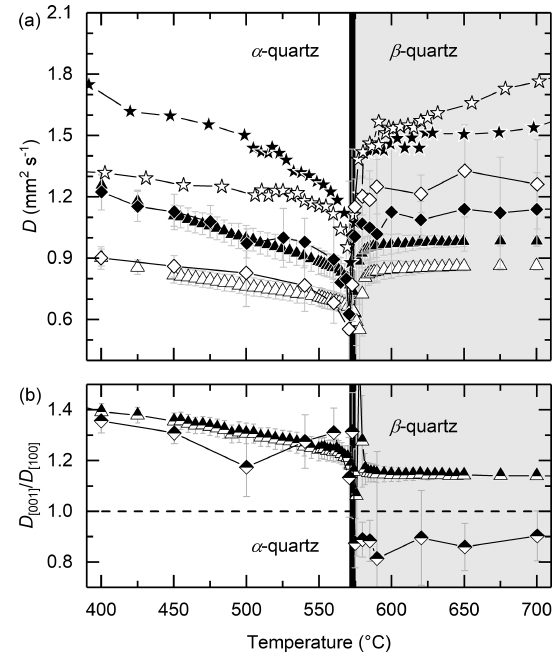
Figure 4. (a) Thermal diffusivities in the [001] (black filling) and [100] directions (white filling) measured for a cubic quartz speci- men with thickness d ∼ 10mm (diamonds) in comparison to HT1 data (upwards triangles, this study) and measurements given by Höfer and Schilling (2002) (stars). A crossover in the crystallo- graphic direction of the maximum thermal diffusivity is observed for the thick cubic specimen as it was measured for tall cylinders by Höfer and Schilling (2002). (b) Anisotropy of the thermal diffu- sivity shown for HT1 (upwards triangles) compared to data of the cubic quartz specimen (diamonds). The crossover in the thermal dif- fusivity D at the phase transition (a) is represented by a decrease of the anisotropy D [ 001 ] /D [ 100 ] below 1.0 (dashed line), whereas the specimen’s HT1 anisotropy stays above 1.0 at all temperatures. As indicated by the error bars, the data showing the observed crossover for the thick cubic sample are at the limit of the experimental reso-